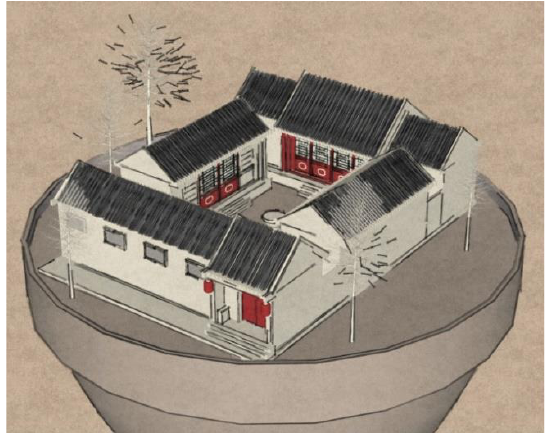
Figure 6 . VR Scenes. Source: "Warm Inheritors" Team After the program's visual designs of the art assets were completed, data, which included movements, cultural relics, and sounds, were collected. The authors invited the inheritors to capture the motion data and sounds in a motion capture laboratory. Models of the scenes and characters were low poly models used to reduce the computational burdens on the system and create a smooth experience for the audience. The character models were bound to skeletons, paired with the collected motion data, and adjusted for animation. The completed art assets were uploaded into the Unity3D platform (Figure 7).